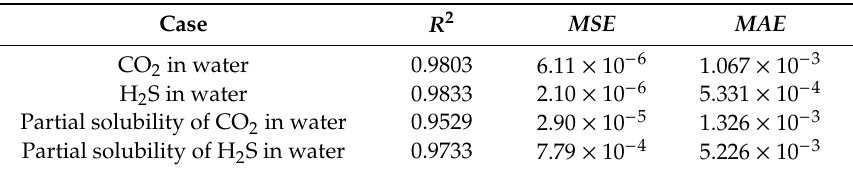
Table 4. Statistical analysis of the correlations.